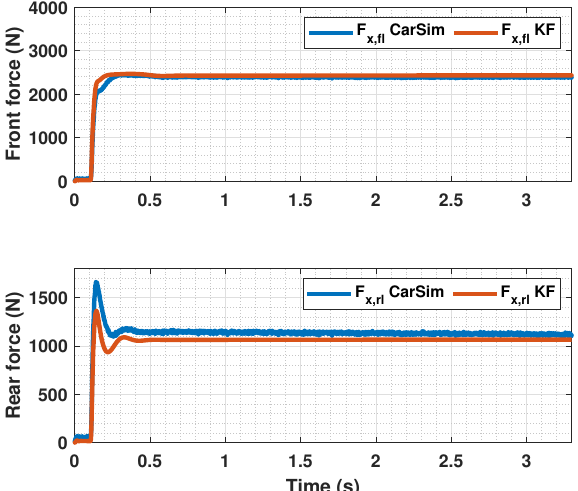
Figure 10. Estimated forces by KF compared with CarSim forces for µ max = 0.40.